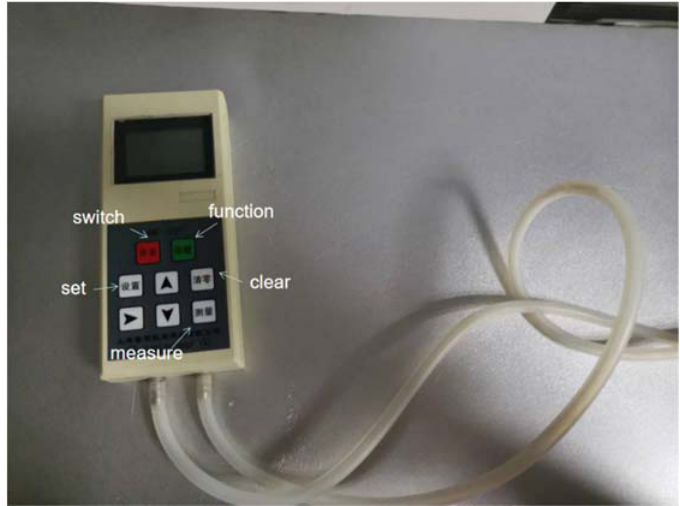
Figure 12. Anemometer.